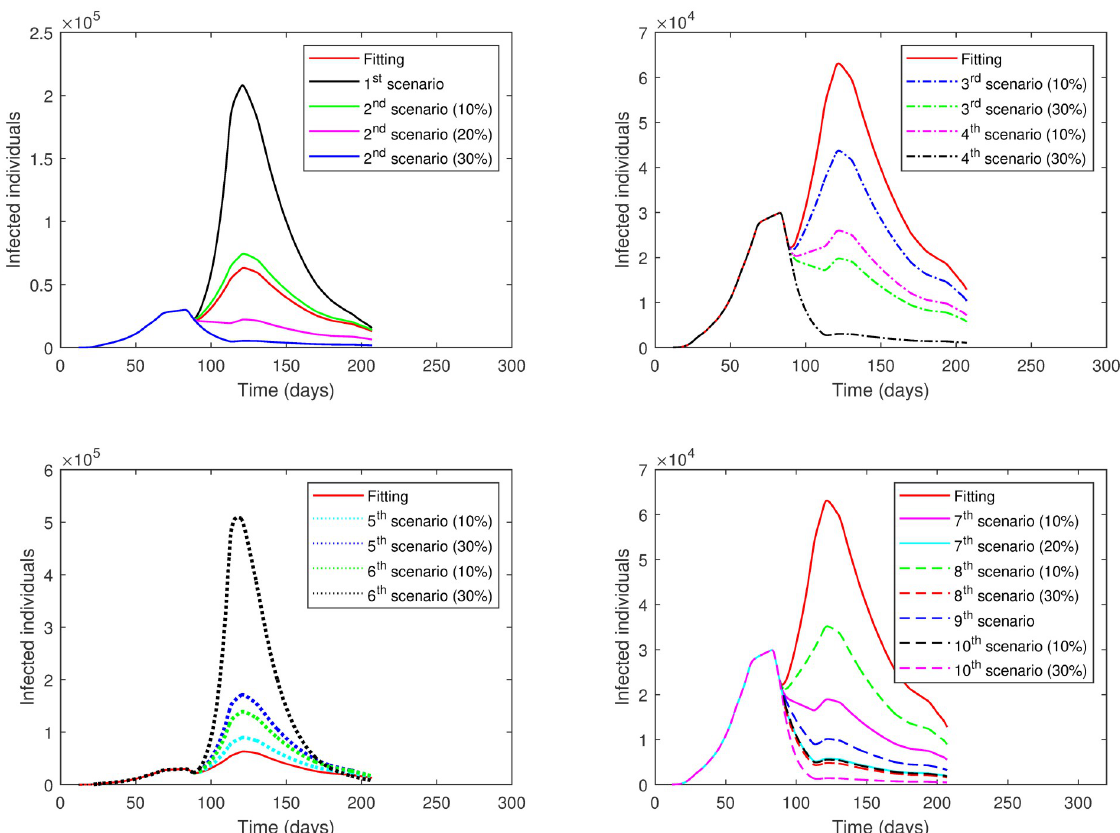
Fig 12. The numerical solution of model (1) for infected compartment vs. time with different scenarios of Phase 6 in the First Case: 1 st scenario, no lockdown is implemented; 2 nd scenario, no lockdown while SD increases; 3 rd scenario, lockdown increases; 4 th scenario, SD increases; 5 th scenario, lockdown decreases; 6 th scenario, SD decreases; 7 th scenario, lockdown and SD increases; 8 th scenario, lockdown decreases and SD increases; 9 th scenario, ρ is the same as in Phase 5; 10 th scenario, ρ is the same as in Phase 5 while SD increases.